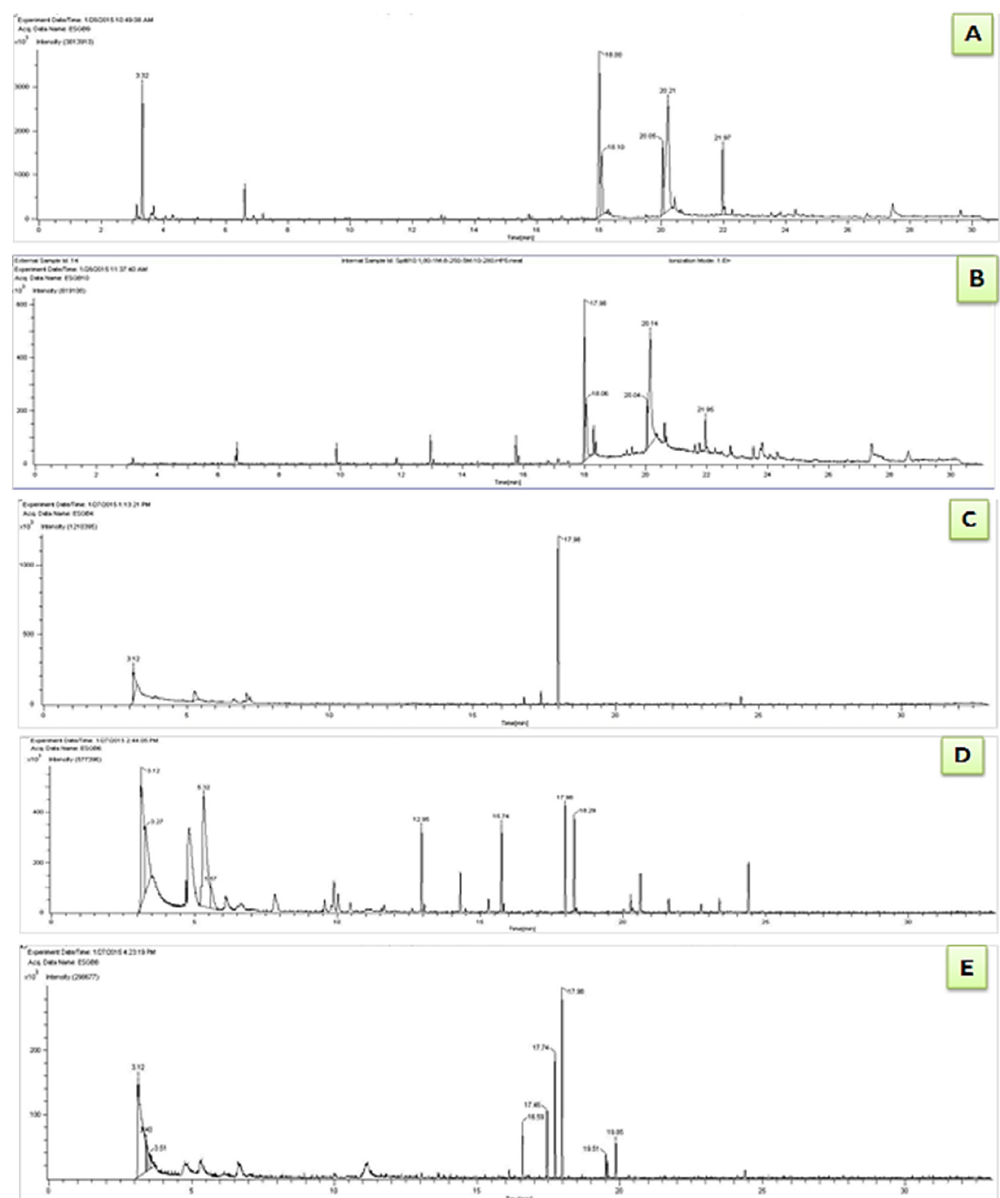
Figure 4. Gas Chromatography-Mass Spectrometry (GC-MS) chromatograms of A) petroleum ether B) chloroform C) acetone D) ethanol E) methanol seeds